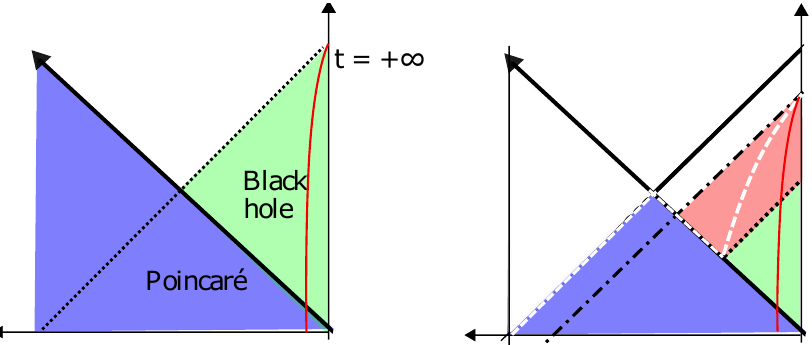
Figure 7 . Left: creation of a black hole by sending in a pulse in the Poincar(cid:19)e patch. The dashed line represents the black hole horizon as described in the black hole frame. The red line is the holographic boundary curve. Right: evaporating black hole structure. The blue region is the original Poincar(cid:19)e patch. After the initial pulse passes, the boundary observer lives in the red evaporating patch which encompasses the green (non-evaporating) frame. The white dashed line represents the apparent horizon which jumps from the initial Poincar(cid:19)e extremal horizon to the would-be horizon in the non-evaporating case and then recedes back as the evaporation